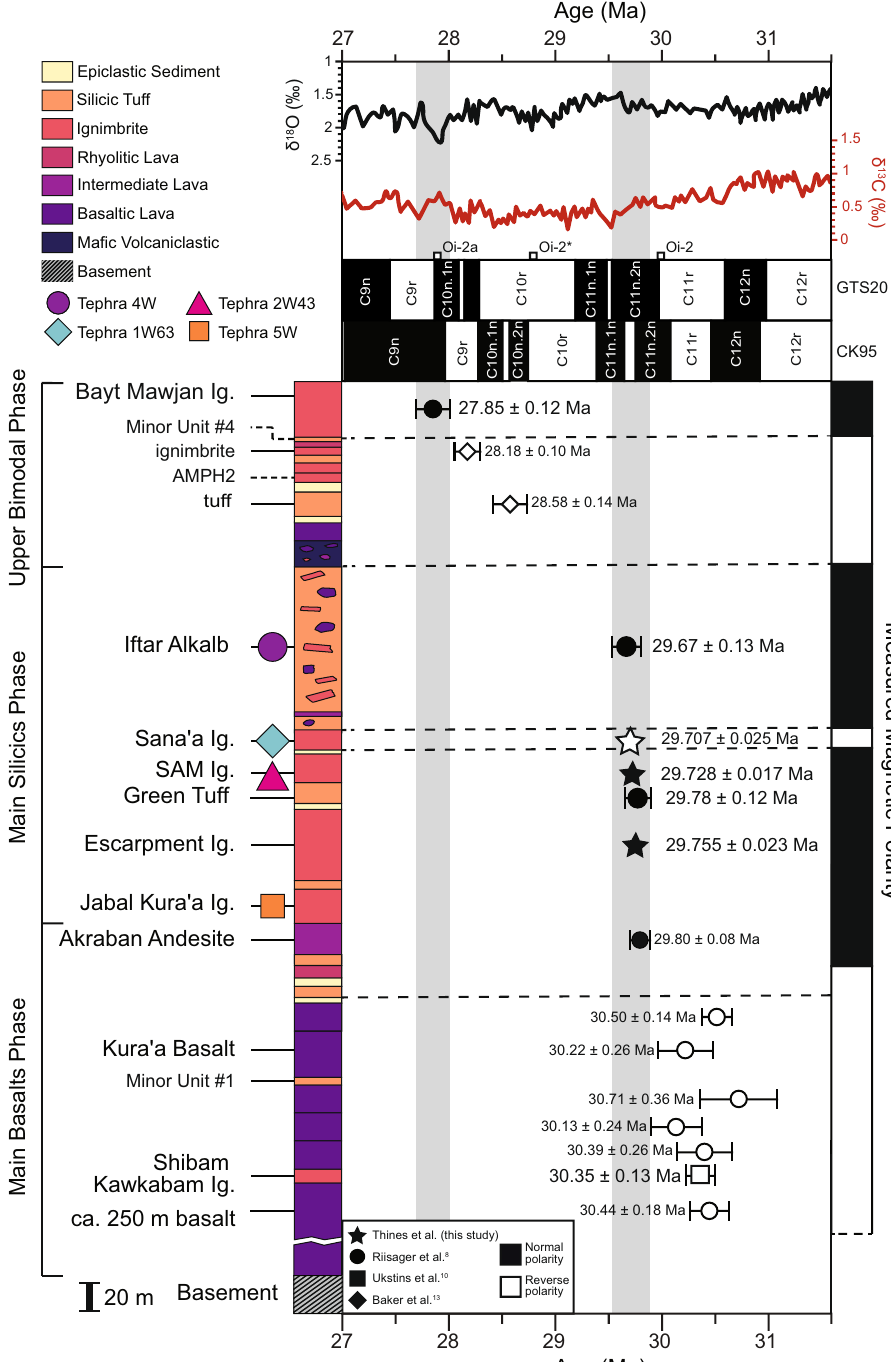
Fig. 2 Composite stratigraphy of Northern Yemen bimodal fl ood volcanic units showing paleomagnetic and geochronologic data. Composite stratigraphy is shown using the average thickness of each unit 9 . Four units have been correlated to Indian Ocean tephra layers 12 and are annotated by the colored symbols. Paleomagnetic data 8 are indicated where white = reverse polarity and black = normal polarity. Dashed lines show the approximate locations of the paleomagnetic reversals in the stratigraphy. Minor Unit #4 and AMPH 2 are from different sample localities and both underlie the Bayt Mawjan Ignimbrite, but their stratigraphic order relative to each other is uncertain. Oligocene fl ood volcanic units overly sedimentary basement (Tawilah Group sandstone) 9 . Symbols for 40 Ar/ 39 Ar ages 8,10,11 are colored based on polarity. The gray fi eld highlights the 40 Ar/ 39 Ar and 206 Pb/ 238 U ages with associated uncertainties of two pulses of Afro-Arabian silicic volcanism. Error bars for 206 Pb/ 238 U and 40 Ar/ 39 Ar ages are 2 σ (Supplementary Data and Supplementary Information, respectively). The Escarpment Ignimbrite, Green Tuff, SAM and Sana ’ a Ignimbrites, and Iftar Alkalb are a set of normal to reversed polarity that encompass the duration of the C11n.1r Subchron and are compared to the GPTS of Cande and Kent 14 as reported in the 2020 Geologic Time Scale 42 . Benthic foraminiferal δ 18 O and δ 13 C curves are from the 2020 Geologic Time Scale 42